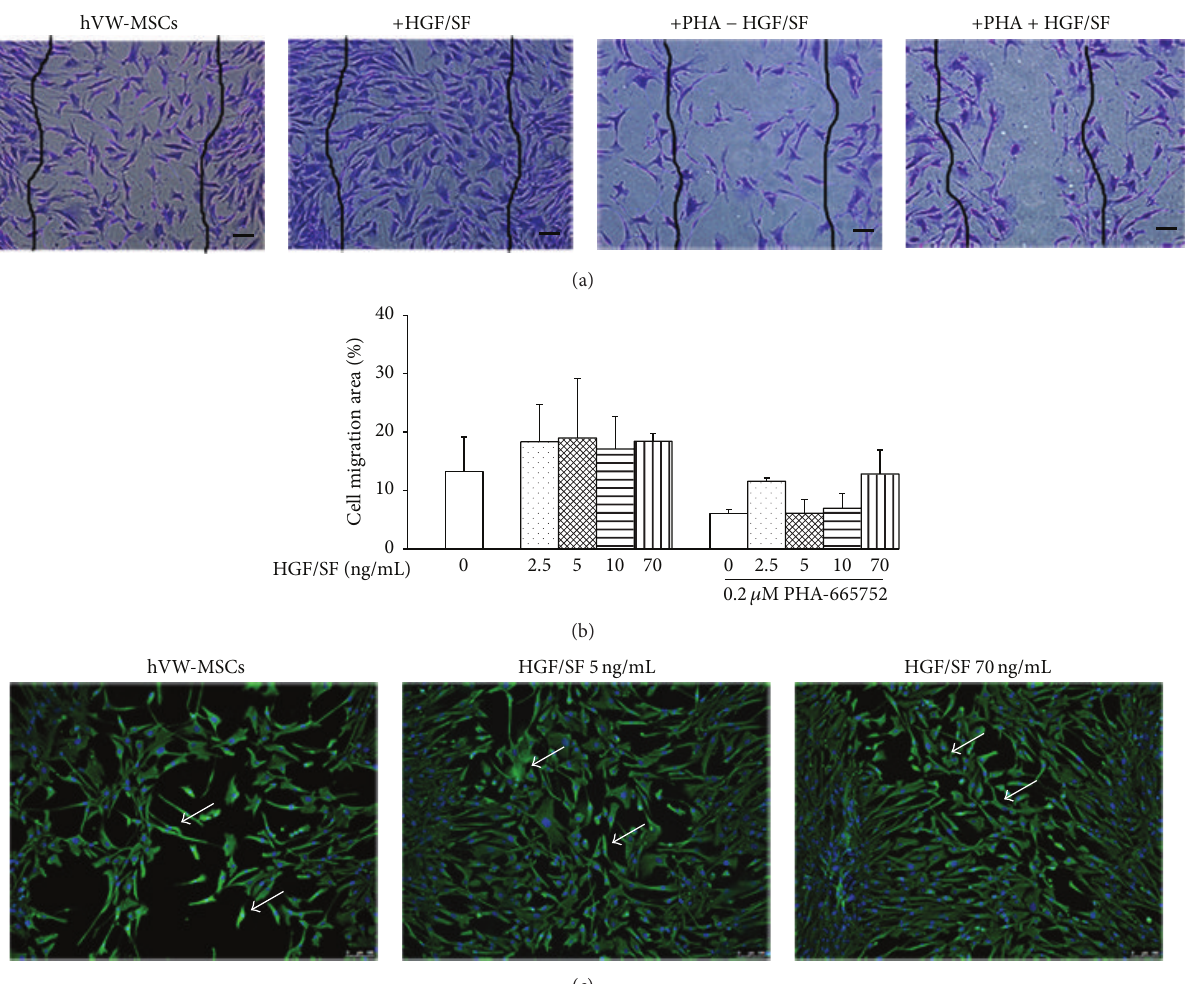
Figure 3: Migratory effect of HGF/SF on hVW-MSC. (a) Crystal Violet staining of hVW-MSCs migrated into the scratch area after 24 hrs of exposure to HGF/SF in comparison to the untreated hVW-MSCs; the cell migration was slackened by PHA-665752 before treatment. Wounded area is delimited by black lines. Scale bars = 50 𝜇 m. (b) Quantitative analysis of cell migration area in hVW-MSCs treated with HGF/SF, in presence and absence of PHA-665752. (c) Immunofluorescence staining for Vimentin revealed that the intermediate filaments Vimentin (positive (green)) was markedly stained in migrated cells (arrows) then unmigrated cells. Scale bars = 100 𝜇 m. The reported images are representative of three independent